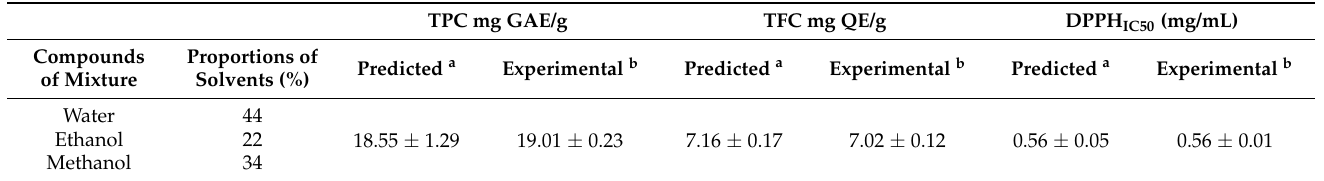
Table 5. Predicted and experimental values for the test point realized by the optimal found